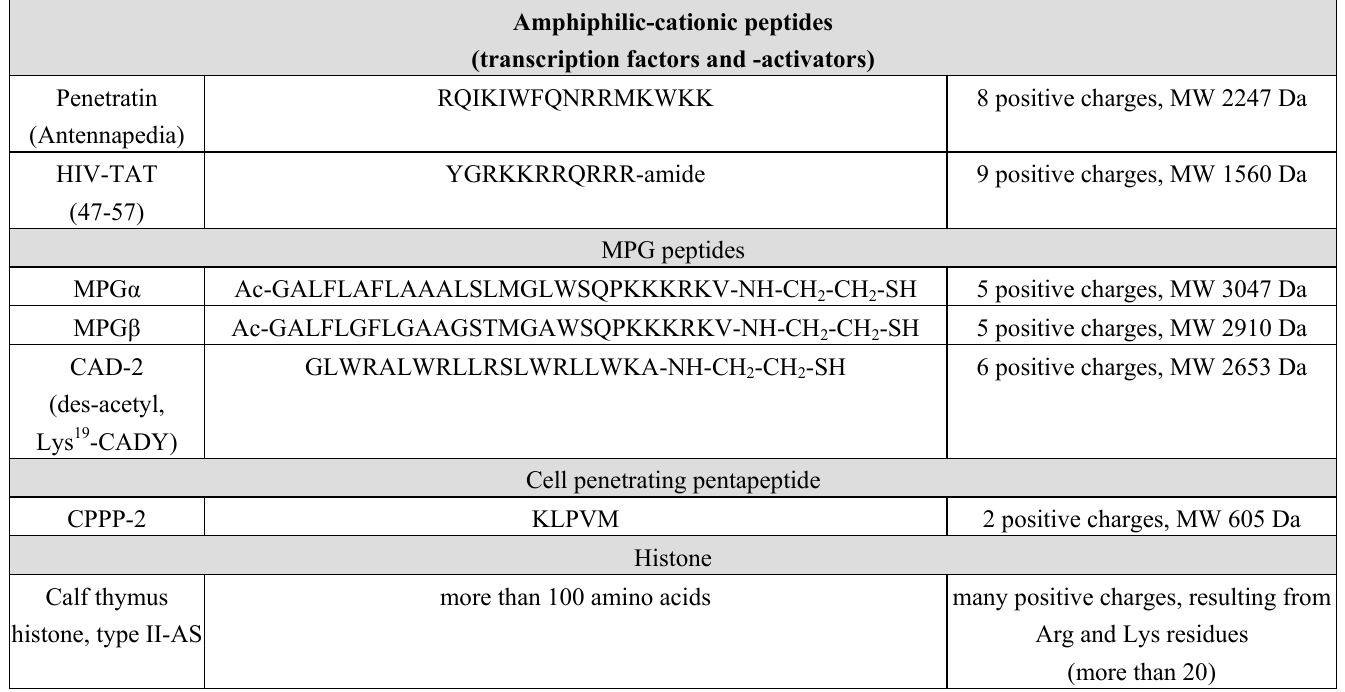
Table 1. Cell penetrating peptides used in the presented